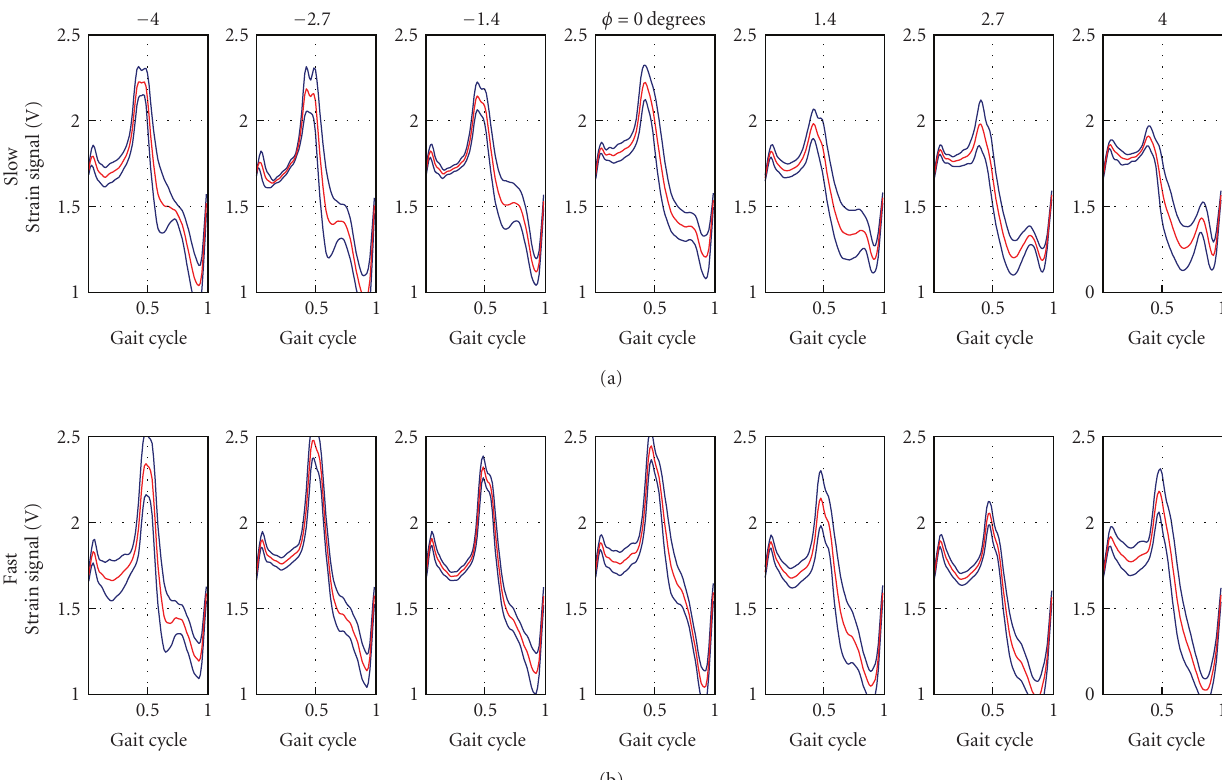
Figure 4: Mean strain signal (red) from test subject B, during a normalized gait cycle, from t start to t start , at seven di ff erent ground inclinations − 4 ◦ to 4 ◦ , and two speeds: slow speed (0.5m/s) and fast speed (1.0m/s). The standard deviations are plotted in